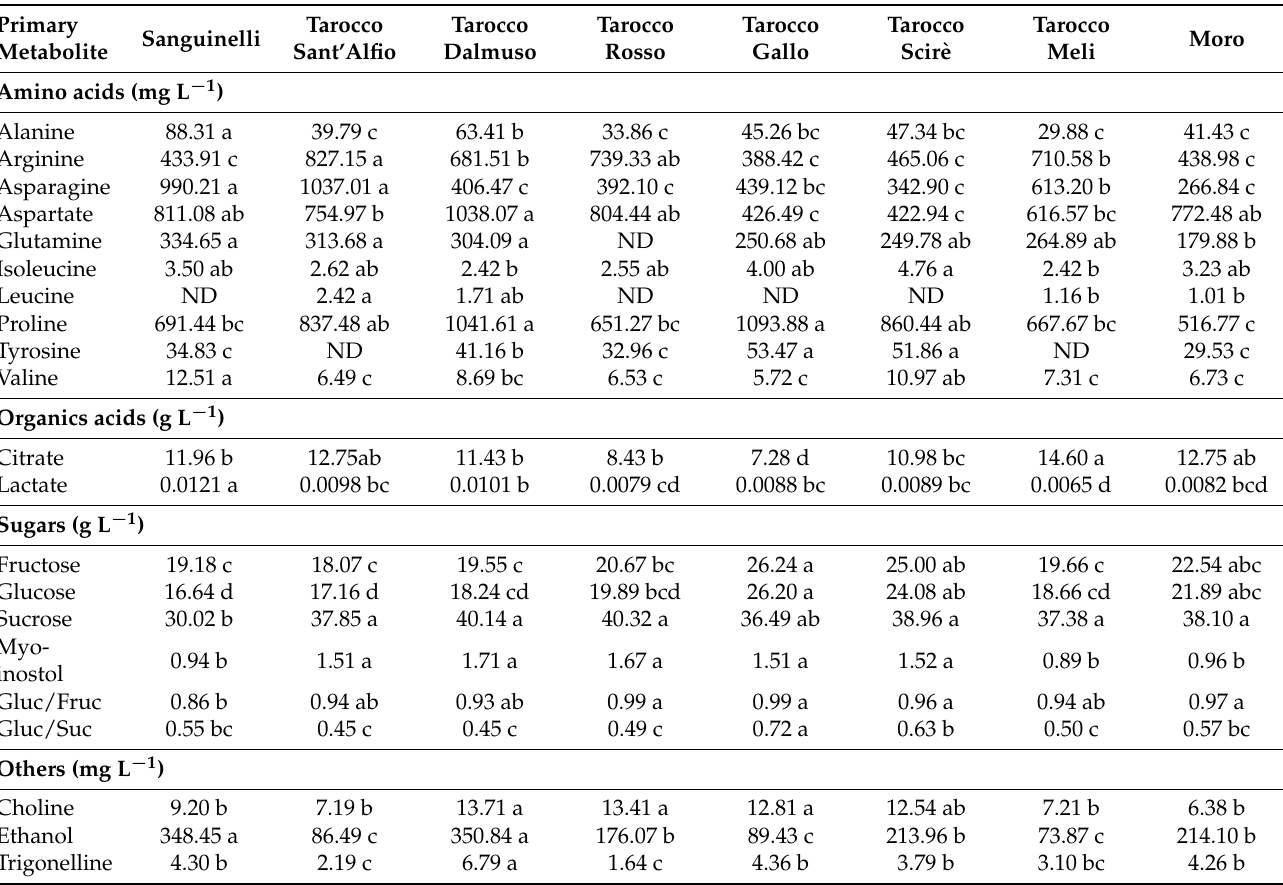
Table 3. Individual content of amino acids, organic acids, sugars and others metabolites in juice of eight blood orange varieties (Sanguinelli, Tarocco Sant’Alfio, Tarocco Dalmuso, Tarocco Rosso, Tarocco Gallo, Tarocco Scir è , Tarocco Meli and Moro) grafted on Citrus macrophylla